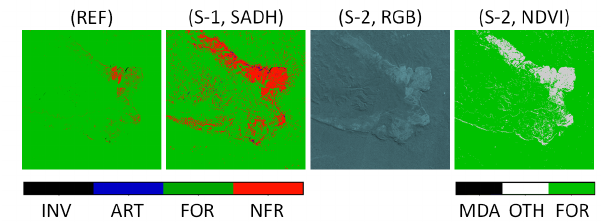
Figure 9. Comparison between, from left to right, the selected reference (REF), the final result of the Random Forests algorithm (S-1, SADH) and the True Color (S-2, RGB) and NDVI (S-2, NDVI) map extracted from the best Sentinel-2 acquisition within the same observation month. The analyzed 1024 × 1024 pixels patch corresponds to an area located around the mount Tracoa, in the Pacaás Novos National Park, Rondonia State,